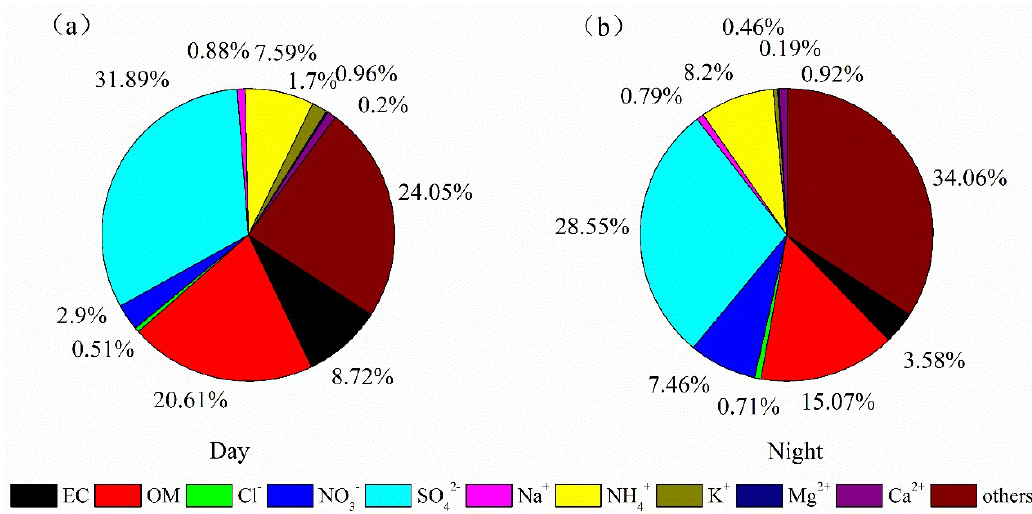
Figure 3. Chemical composition of PM 2.5 by day and by night in the rural regions of Guanzhong Plain, Northwest China: ( a ) for day, ( b ) for night.